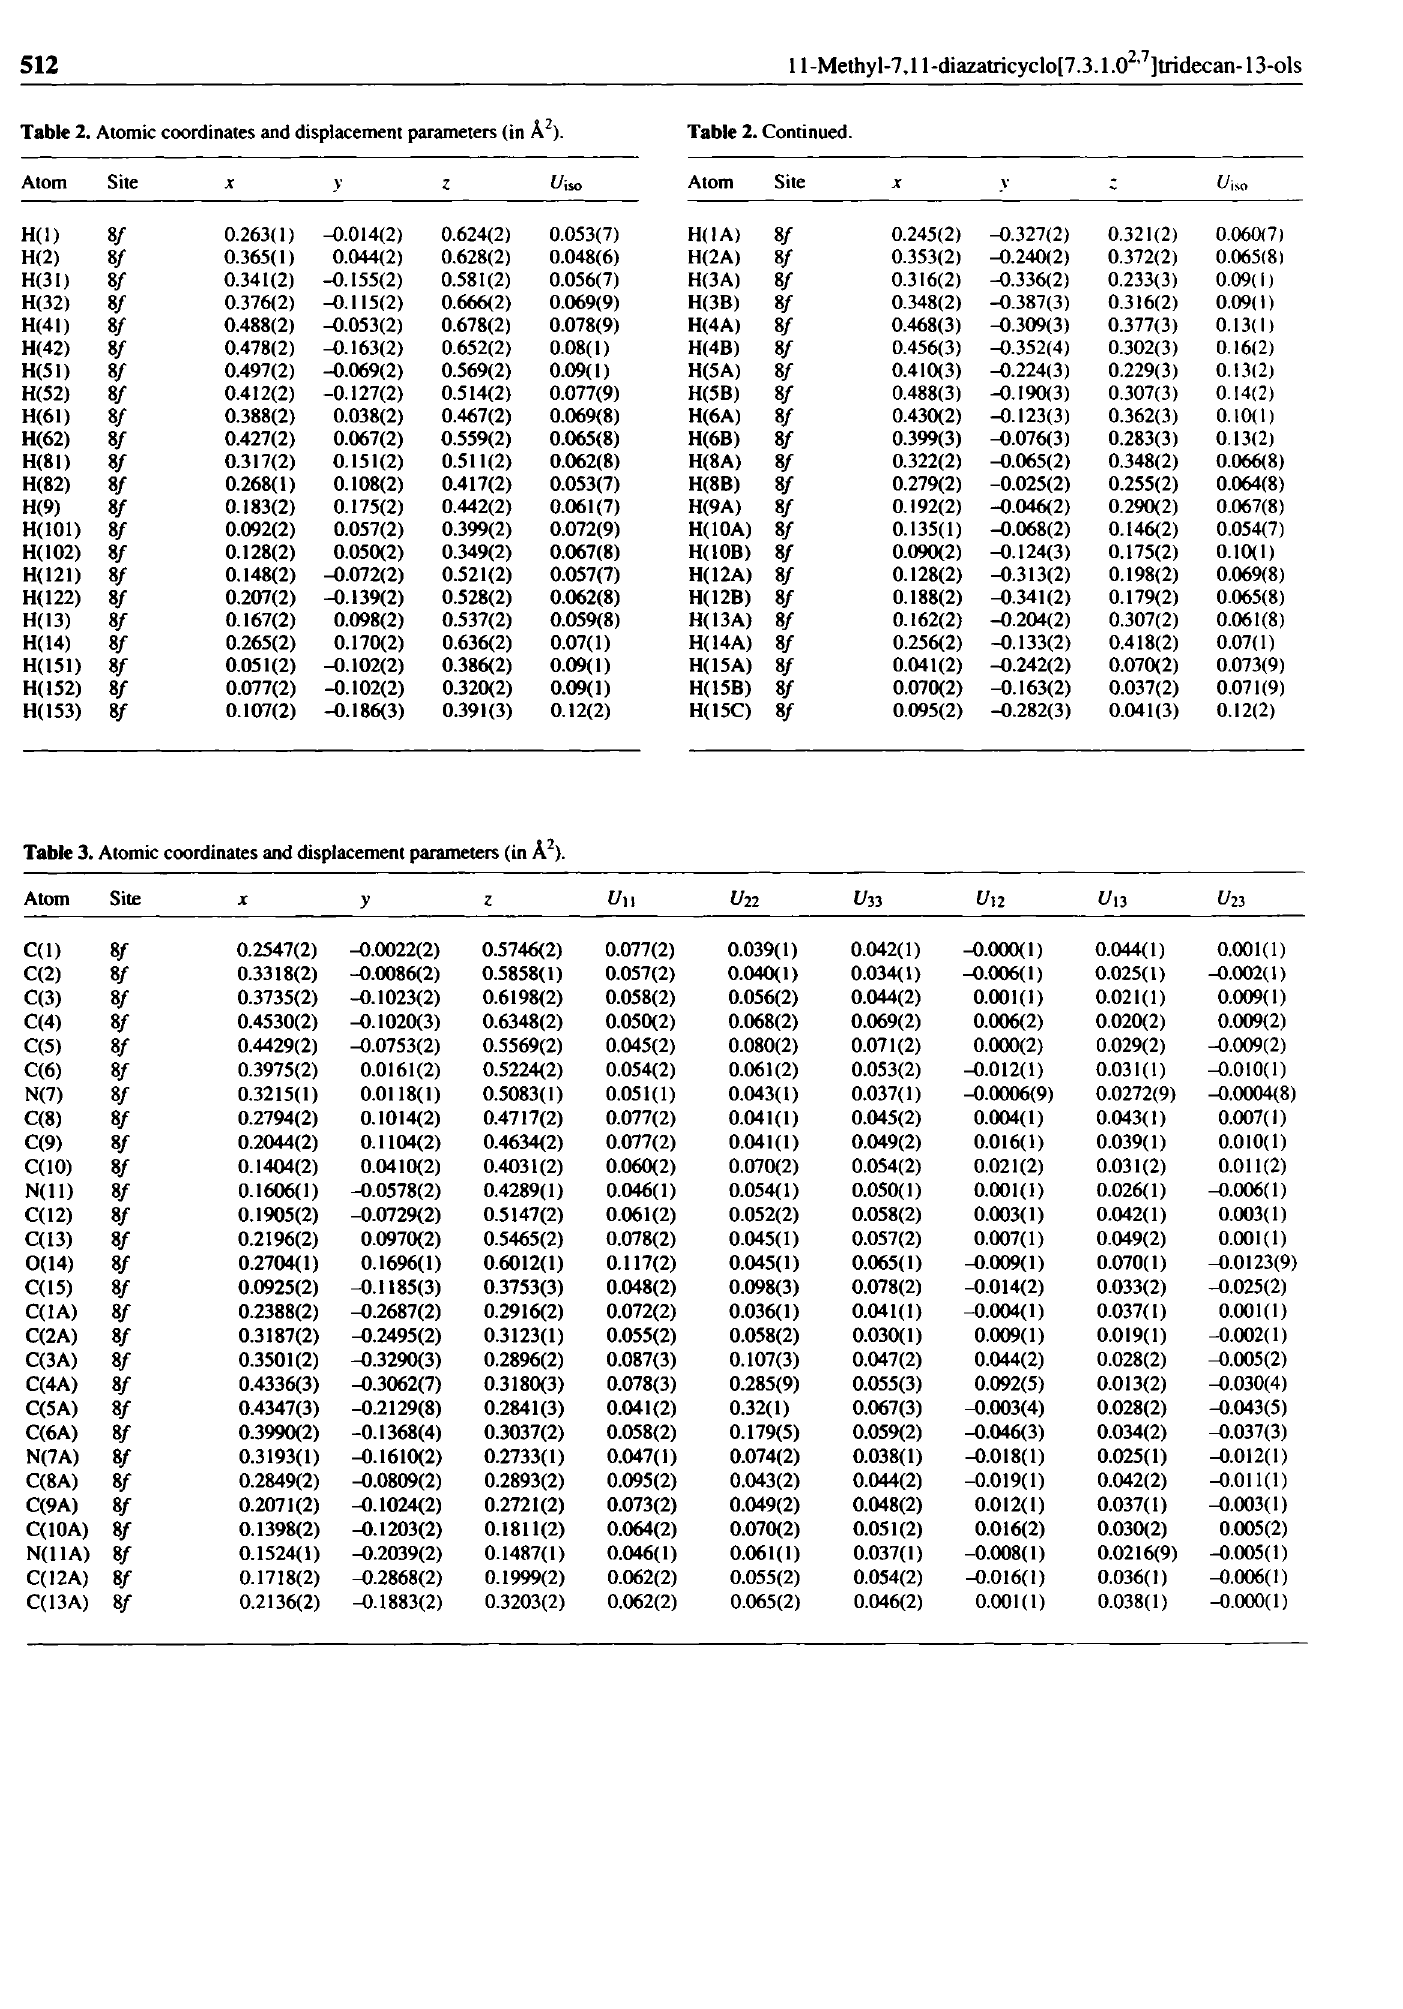
Table 3. Atomic coordinates and displacement parameters (in Ä 2